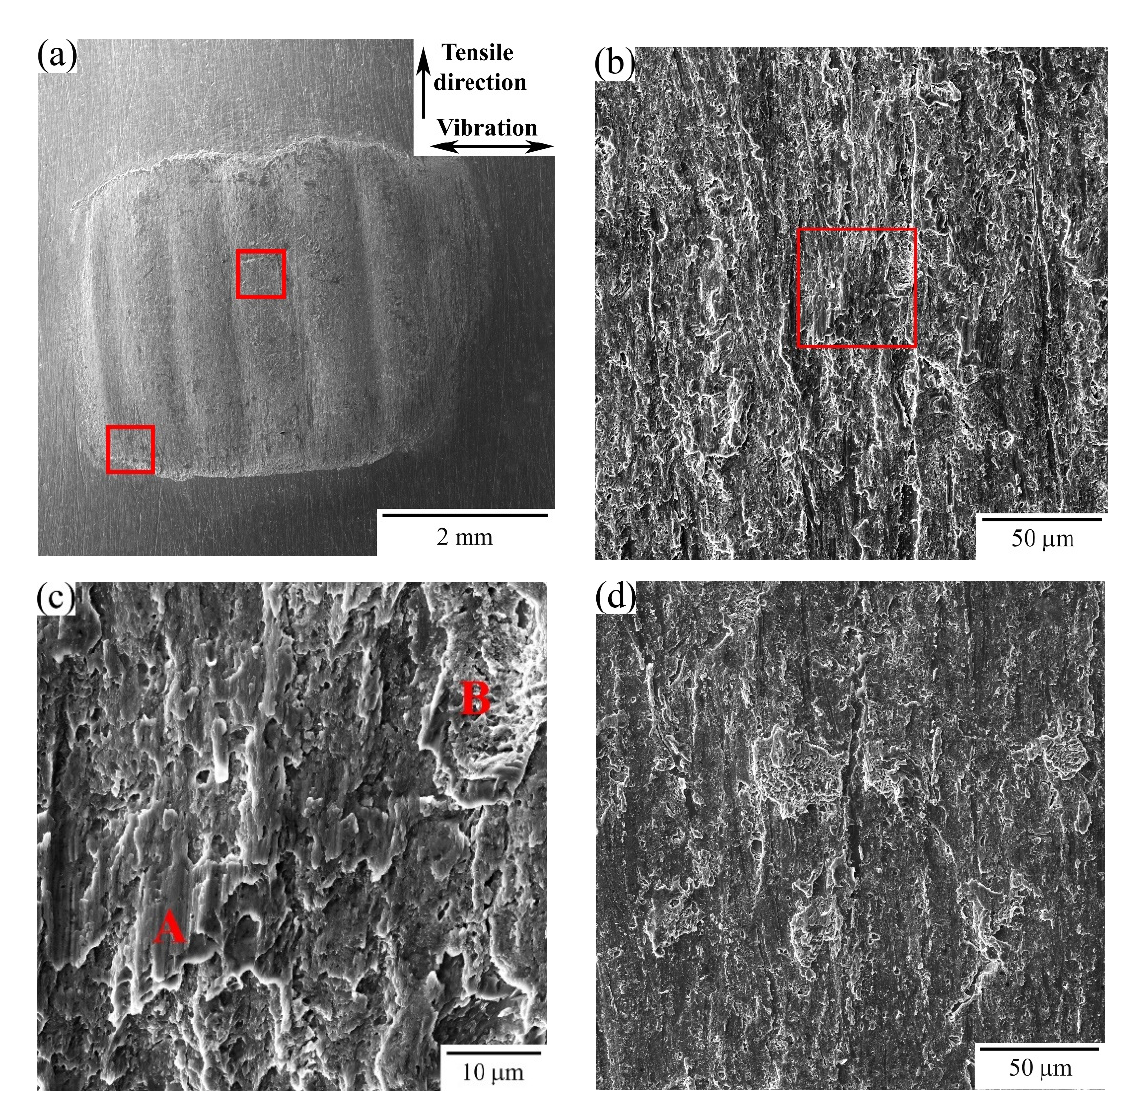
Figure 6. Typical SEM images of lap shear fracture surfaces of coarse-grained welded samples: an overall view ( a ), central zone of the fracture surface ( b ), higher-magnification view of the area in the rectangle in ( b , c ), and peripheral zone of the fracture surface ( d ).